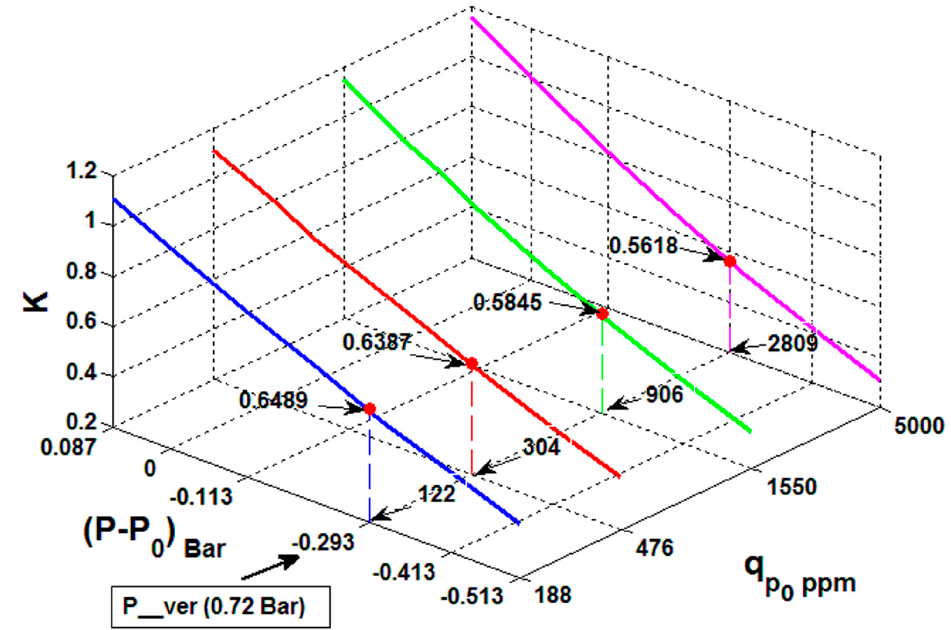
Figure 9. Overall relation between concentration and the compensation parameters. Red dots represent the compensation factor derived for the reference concentrations at pressure 0.72 Bar (equal to Table 4).